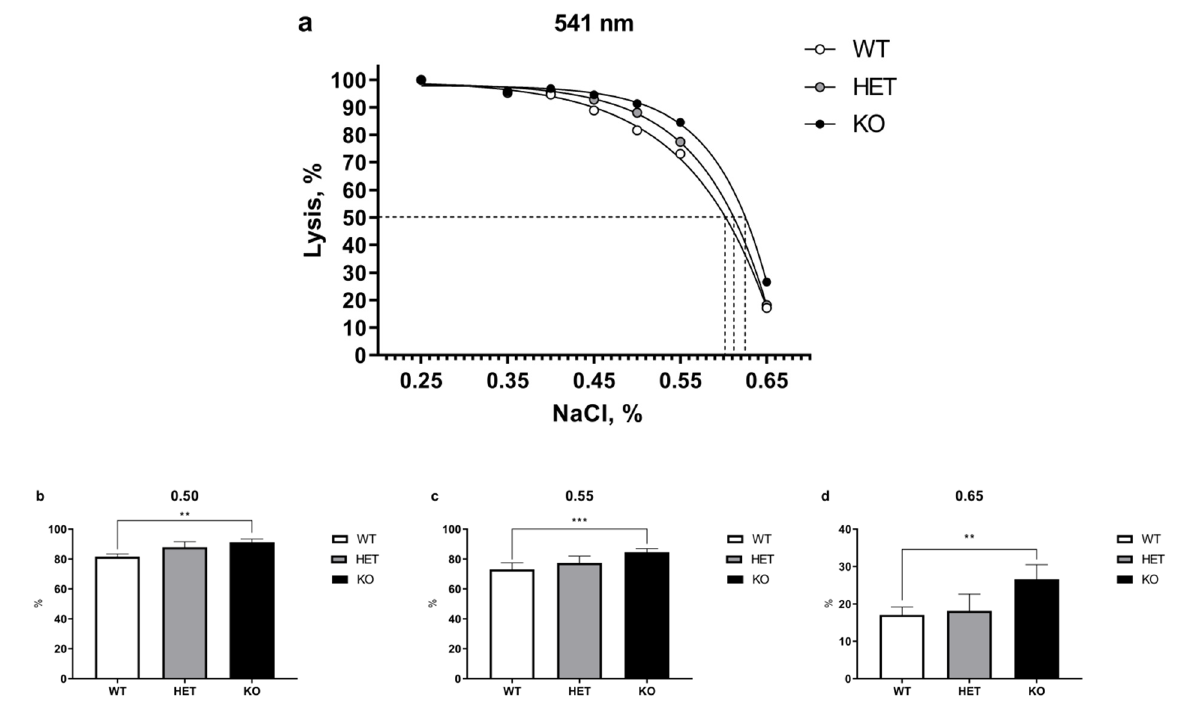
Figure 1. Comparative OFT analysis in the blood of WT, HET, and TAAR5-KO (KO) mice performed at 541 nm wavelength. ( a ) There are significant differences in 0.50, 0.55, and 0.65% NaCl concentration points between KO and WT mice (50% lysis concentration point: WT—0.601, HET—0.612 KO—0.625). ( b )—Statistical analysis of 0.50% NaCl concentration point revealed significant differences between WT and KO groups. ( c )—Statistical analysis of 0.55% NaCl concentration point revealed significant differences between WT and KO groups. ( d )—Statistical analysis of 0.65% NaCl concentration point revealed significant differences between WT and KO groups. Data are mean ± SEM. ** p < 0.01, *** p < 0.001 vs. WT, two-way ANOVA, post-hoc Tukey test.